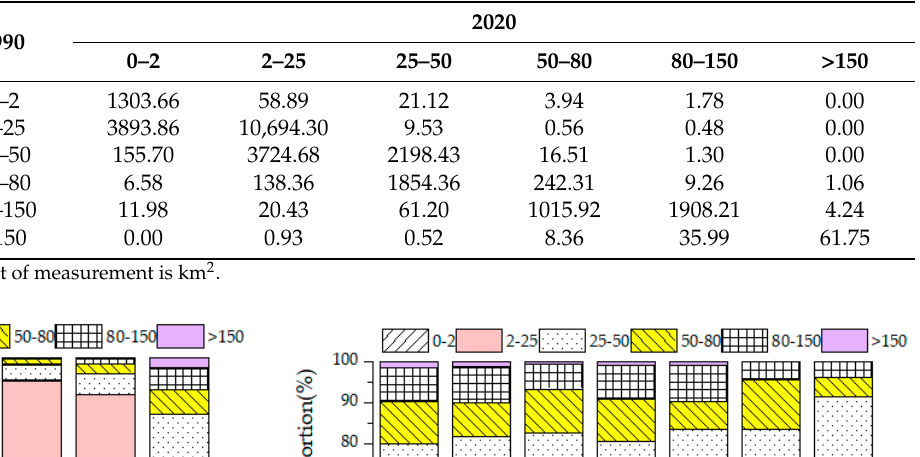
Table 3. Soil wind erosion intensity transfer matrix in Baotou City.